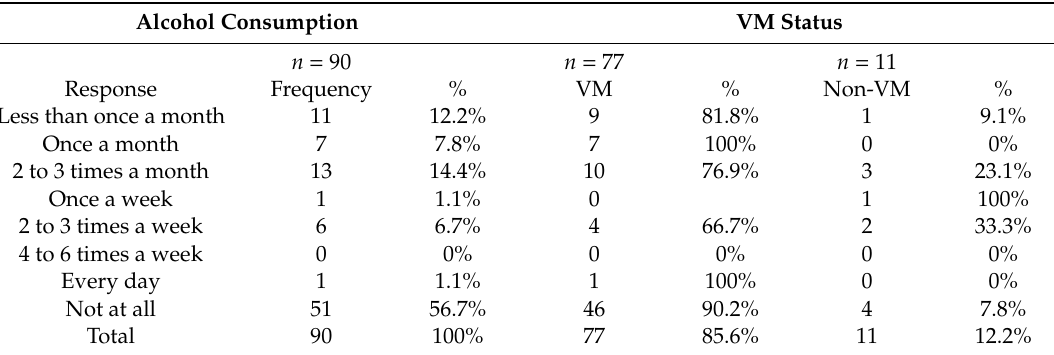
Table 6. Alcohol consumption by VM status.